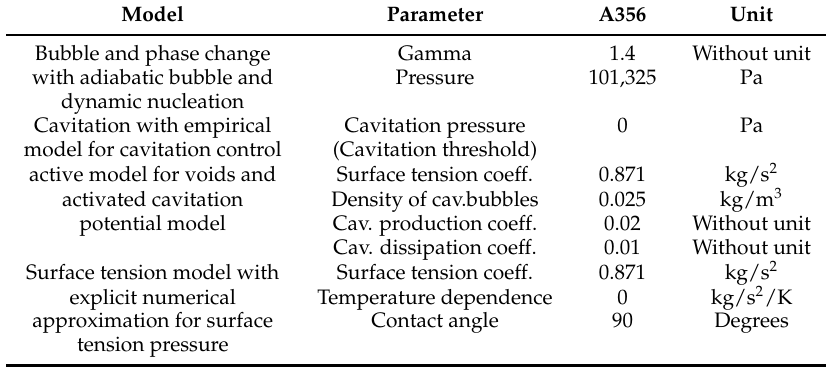
Table 3. Summary of the chosen models with the corresponding